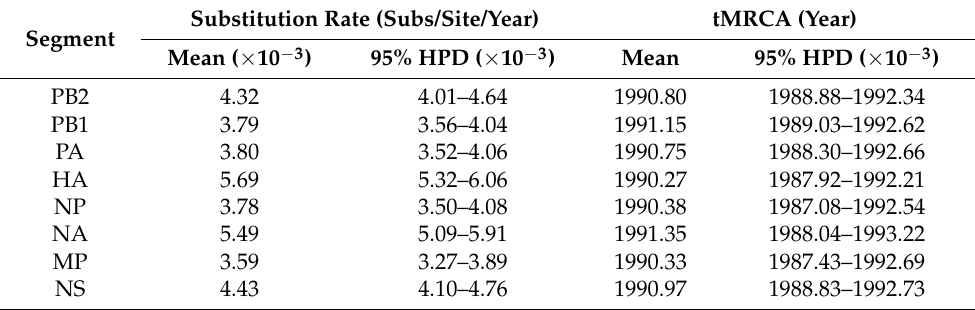
Table 1. Estimates of nucleotide substitution rates and tMRCA for each gene segment of Mexican lineage H5N2